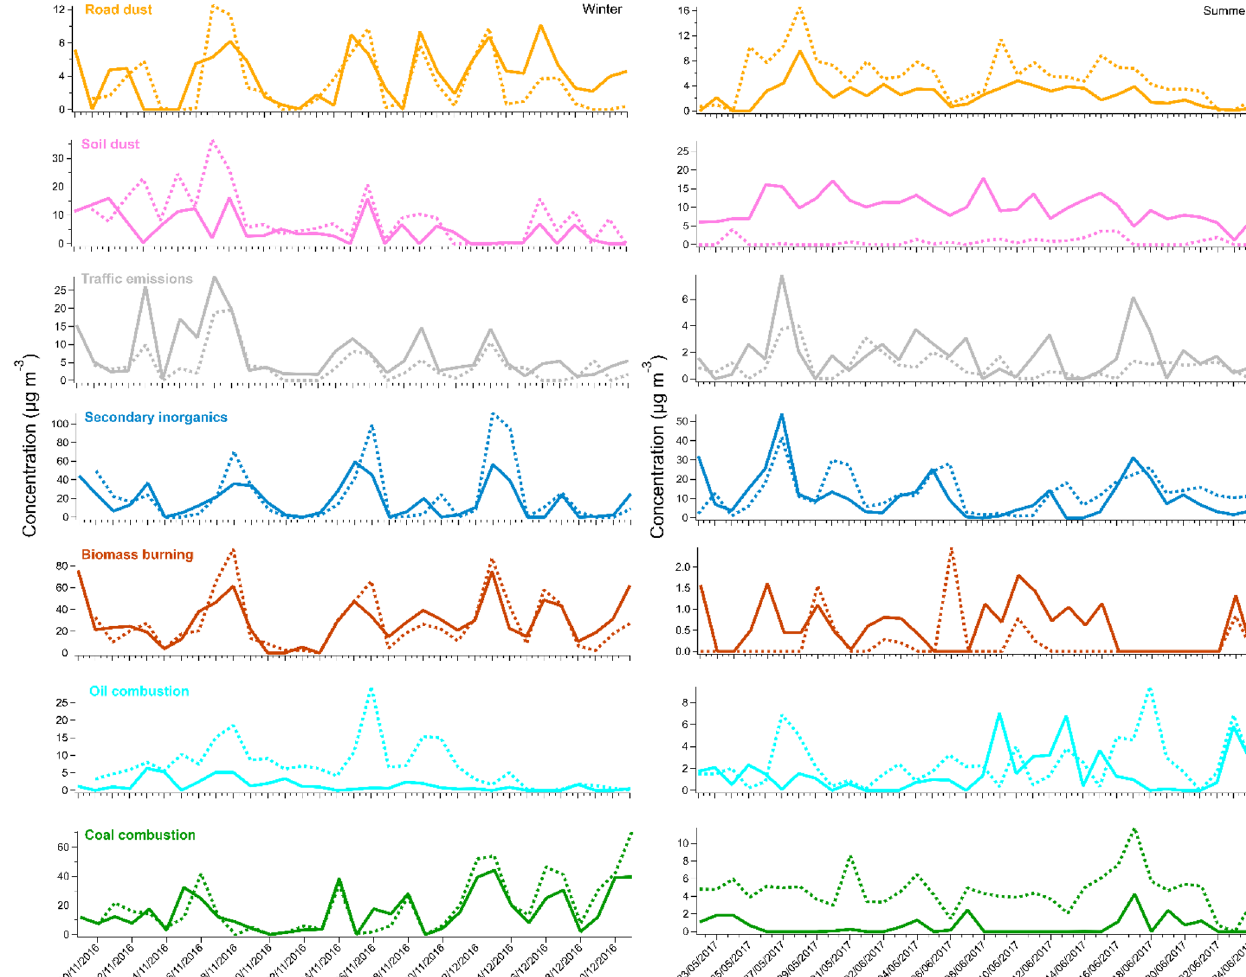
Figure 2. Temporal variation of the identified factors at IAP and PG. Solid and broken lines represent IAP and PG, respectively.